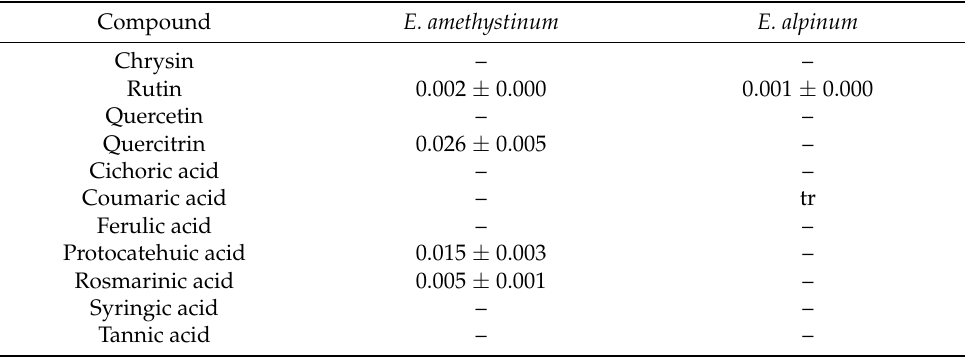
Table 2. Contents of investigated phenolic compounds (%) determined in methanolic